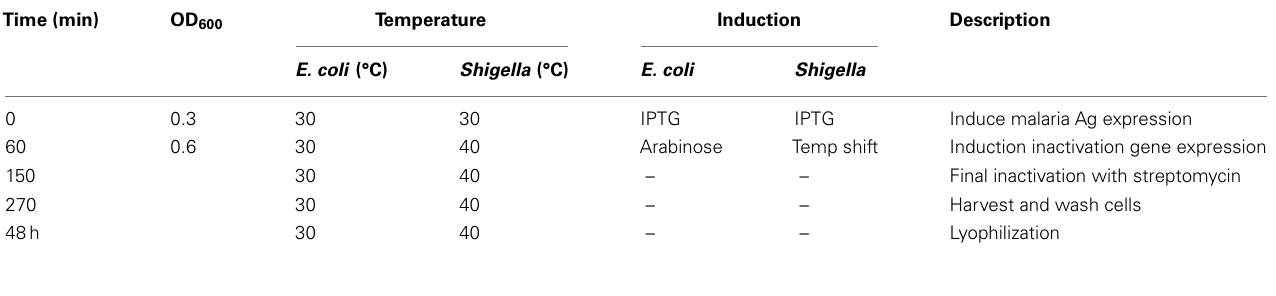
Table 1 | Summary steps for production of GeMI-Vax